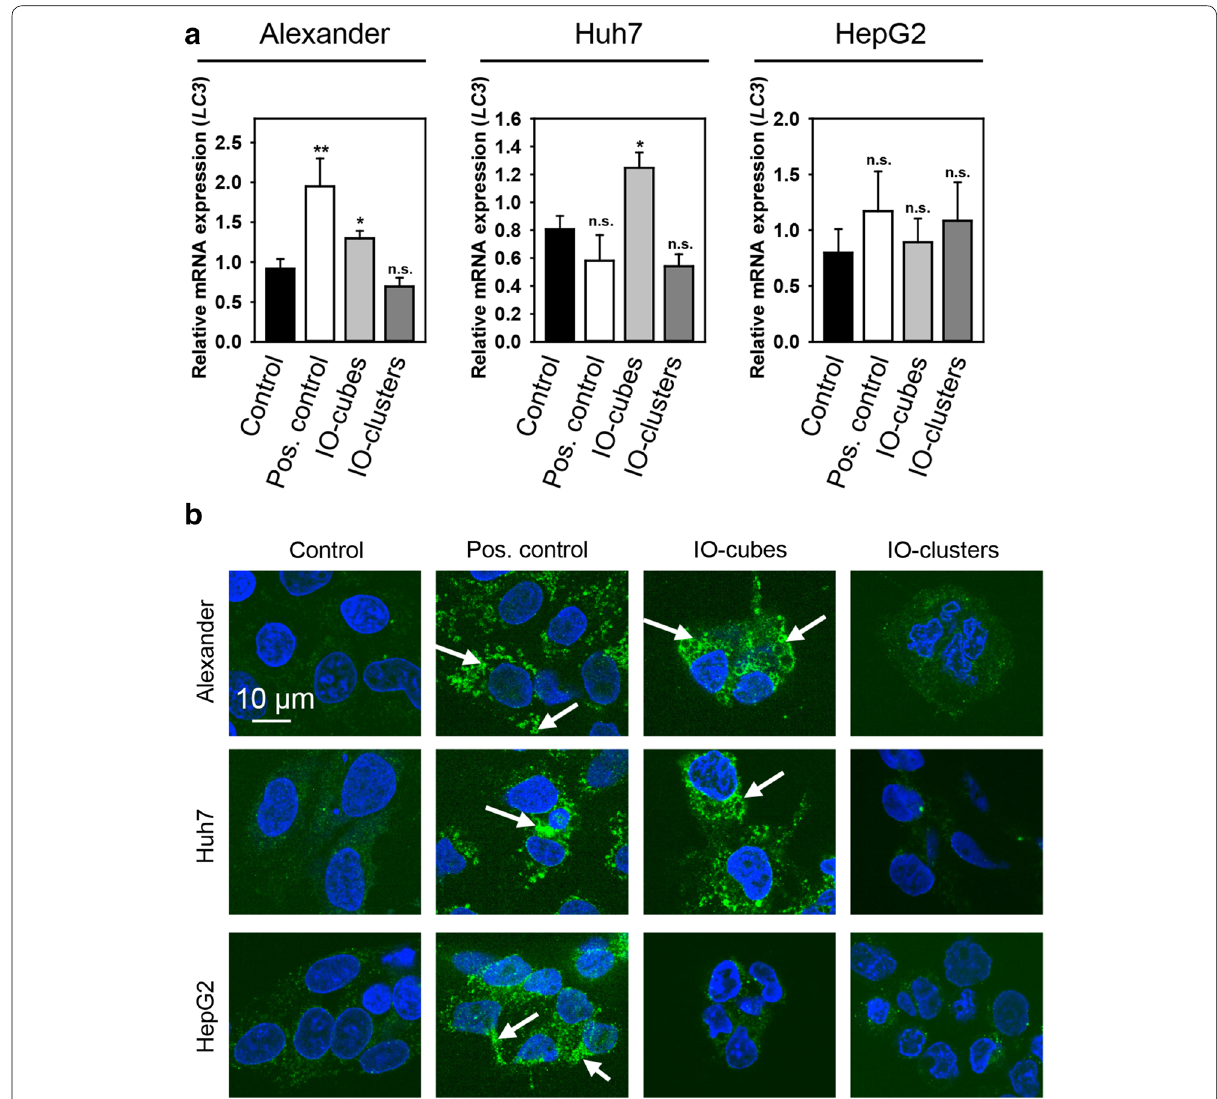
Fig. 6 Monitoring autophagy in cells stimulated with IO-cubes or IO-clusters. a Cells were stimulated with IO-cubes or IO-clusters (100 µg/ mL) for 24 h The relative gene expression was normalized to GAPDH expression, and calculated using the 2 − ΔΔCT method. Cells treated with 2 μM staurosporine for 3 h served as a positive control. Results are mean SEM, ** p < 0.01, * p < 0.05. b Formation of LC3-positive puncta upon ± nanoparticle treatment. Cells were stimulated with IO-cubes or IO-clusters (100 µg/mL) for 24 h, fixed, permeabilized and labeled with LC3A/B (green). Nuclei were labelled with hoechst 33342 nuclear stain (blue). Labeled cells were then imaged using high-resolution spinning disk confocal microscopy (Spin SR, Olympus). White arrows indicate accumulation of autophagosomes. Positive control—serum starvation for 12 (Alexander, Huh7) and 14 (HepG2)